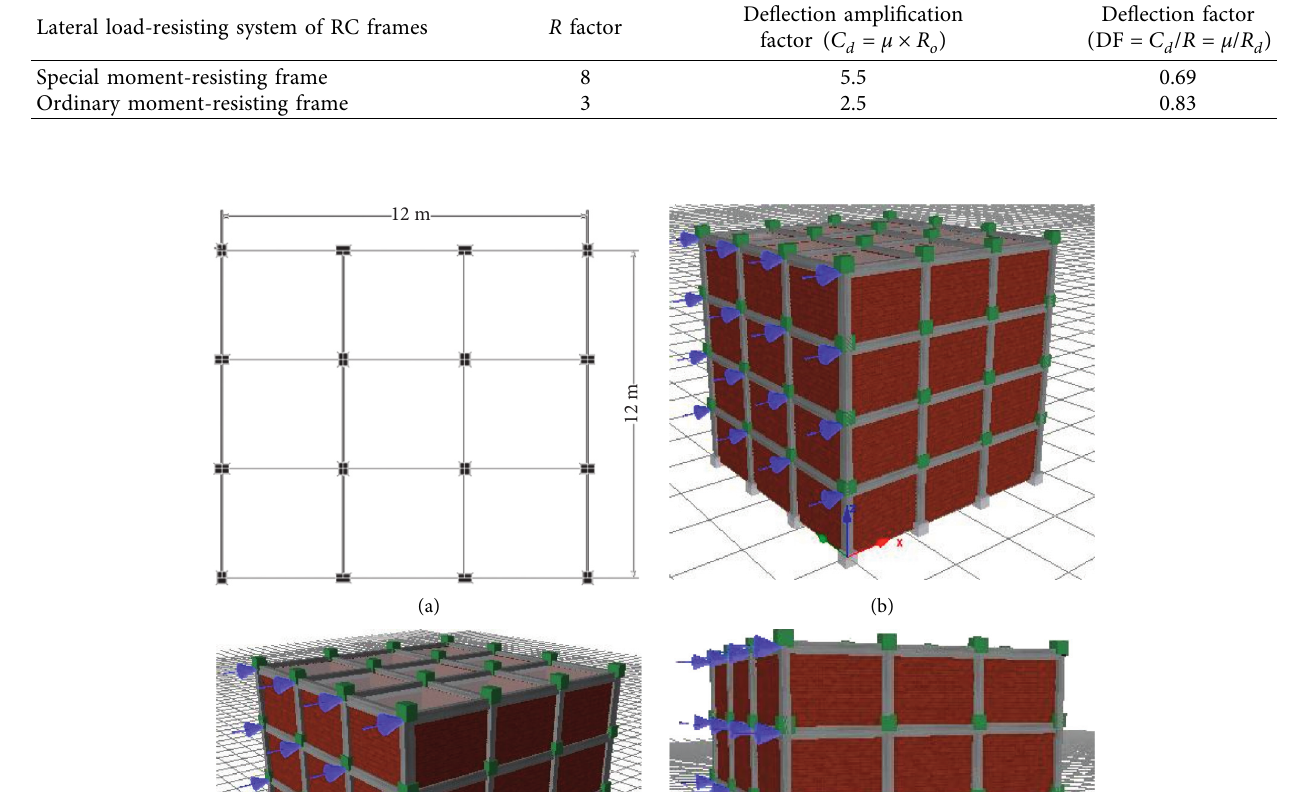
Table 2: Deflection amplification factor in NEHRP [23].